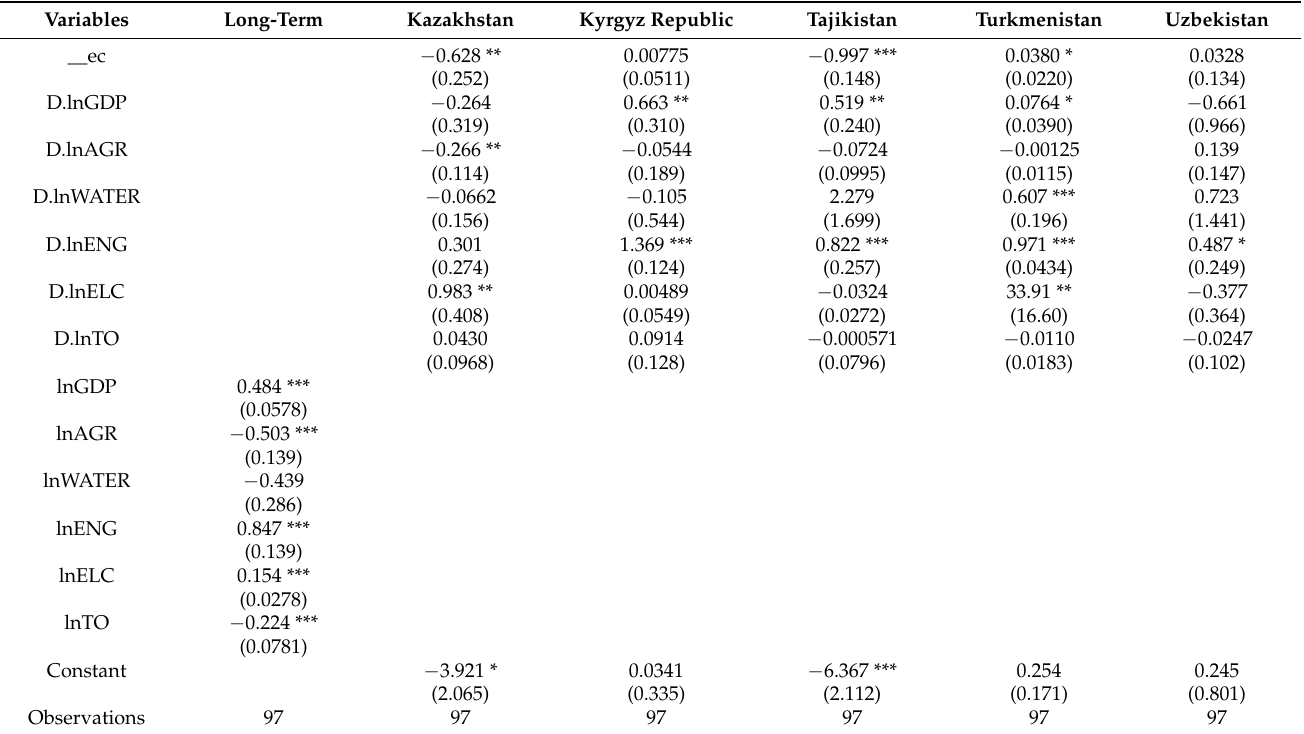
Table 7. Panel ARDL model, PMG